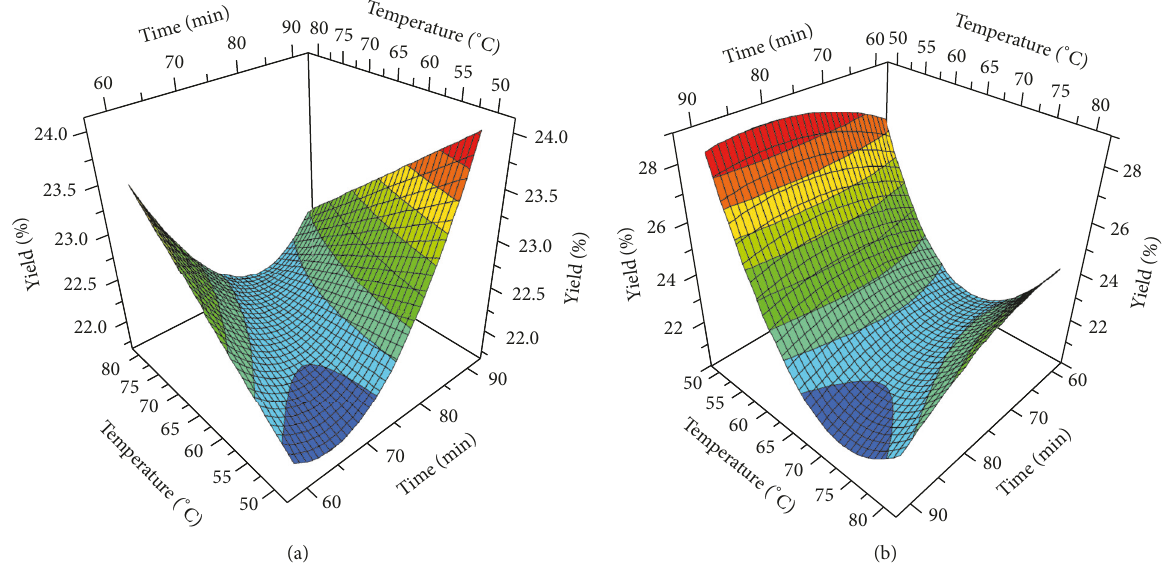
Figure 1: Response surfaces for removal of mucilage extracted from O. cochenillifera : (a) fresh cladodes and (b) dry cladodes.